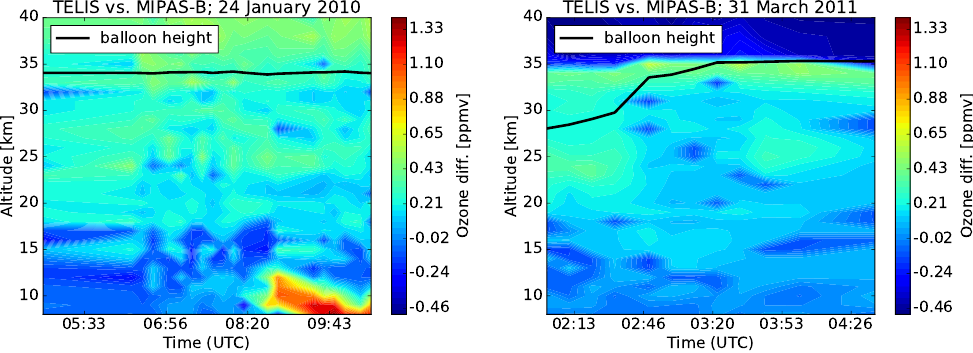
Figure 4. Difference between TELIS and MIPAS-B retrieved O 3 volume mixing ratio (VMR) profiles (TELIS − MIPAS-B) observed on 24 January 2010 and 31 March 2011. Note that both comparisons are plotted with the same difference range. Here, the balloon height is indicated by a solid black